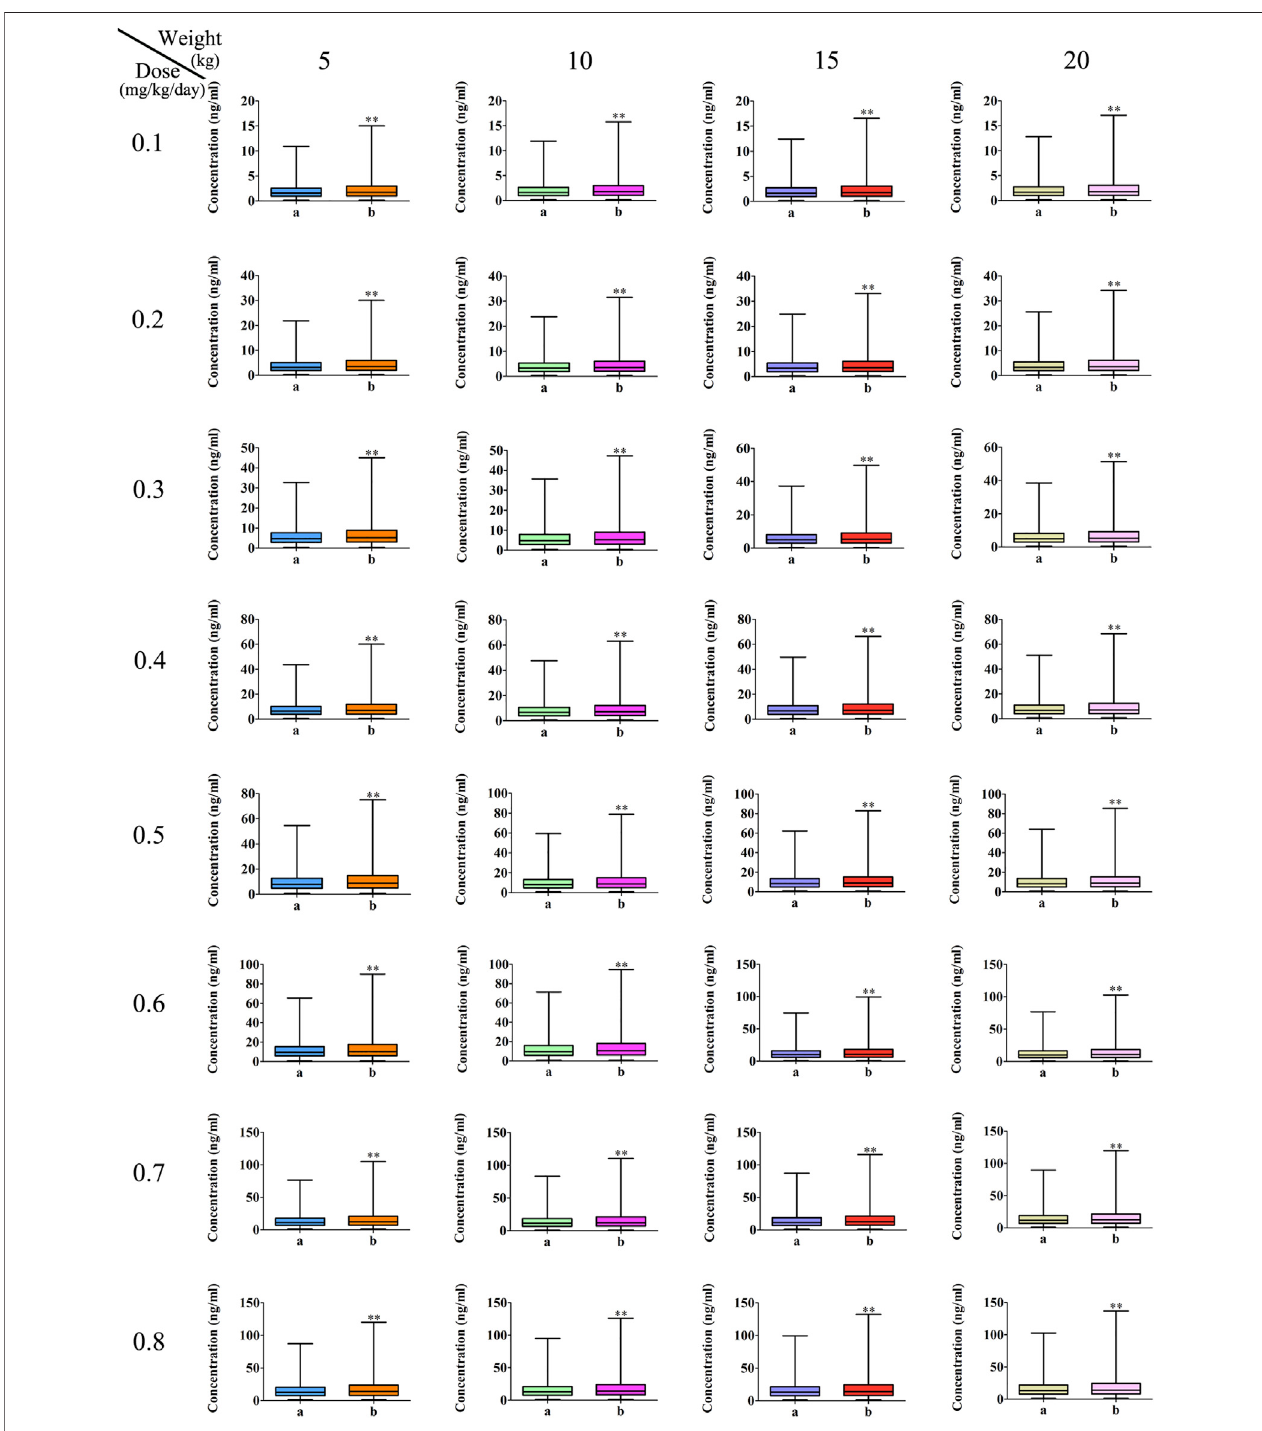
FIGURE 4 | Effects of posaconazole on tacrolimus concentrations. a: without posaconazole. b: with posaconazole. * *p < 0.01 vs. children without posaconazole.